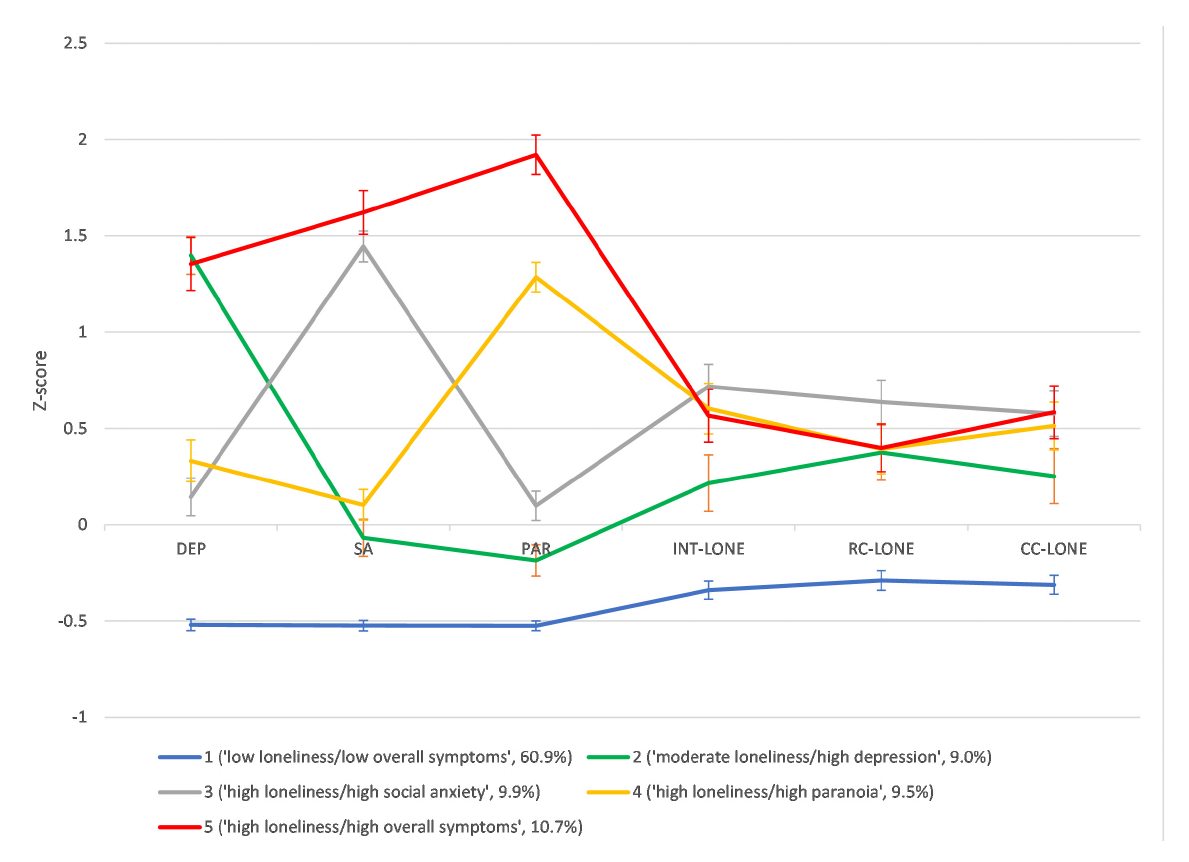
FIGURE1 Z-score profiles and 95% confidence interval of psychopathologies and loneliness dimensions across five profiles. DEP, depression; SA, social anxiety; PAR, paranoia; INT-LONE, intimate loneliness; RC-LONE, relational loneliness; CC-LONE, collective